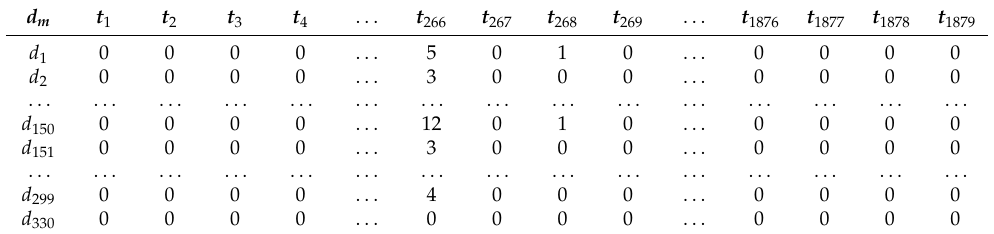
Table 5. Some of the components of